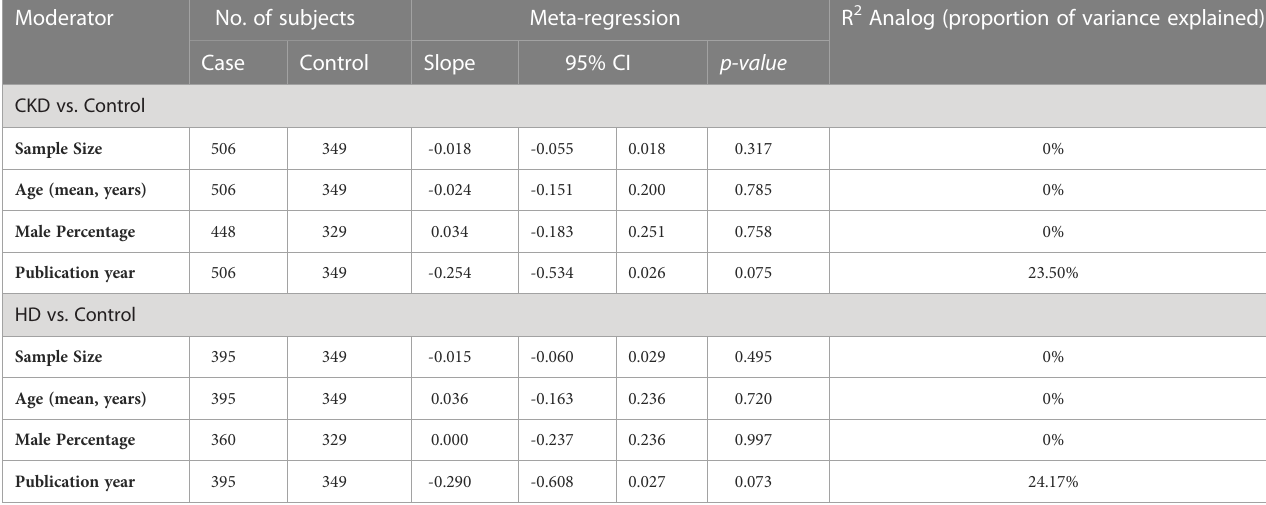
TABLE 2 Meta-regression of CKD/Controls and HD/Controls meta-analyses.